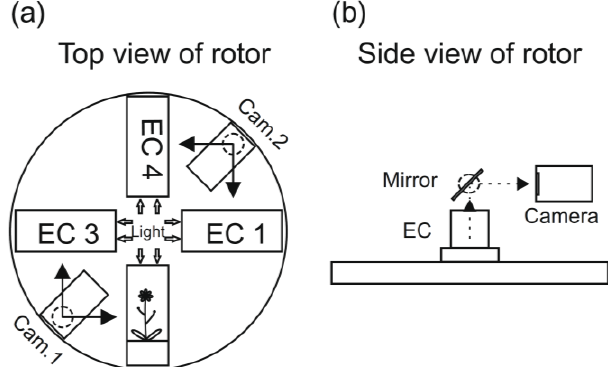
Figure 3. A schematic presentation of the rotor arrangement European Modular Cultivation System (EMCS) ( a ). The ECs are the plant cultivation chambers, and the plants can be photographed using the movable video cameras and with the help of mirrors ( b ) (see